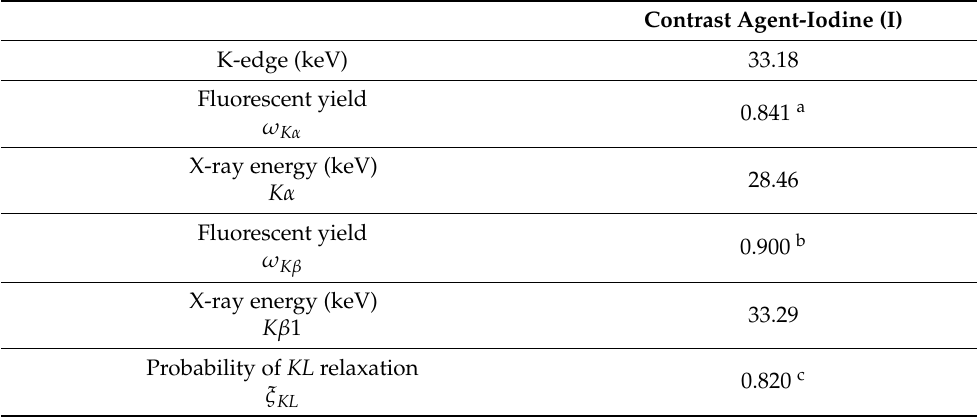
Table 1. Physical parameters and coefficients of iodine